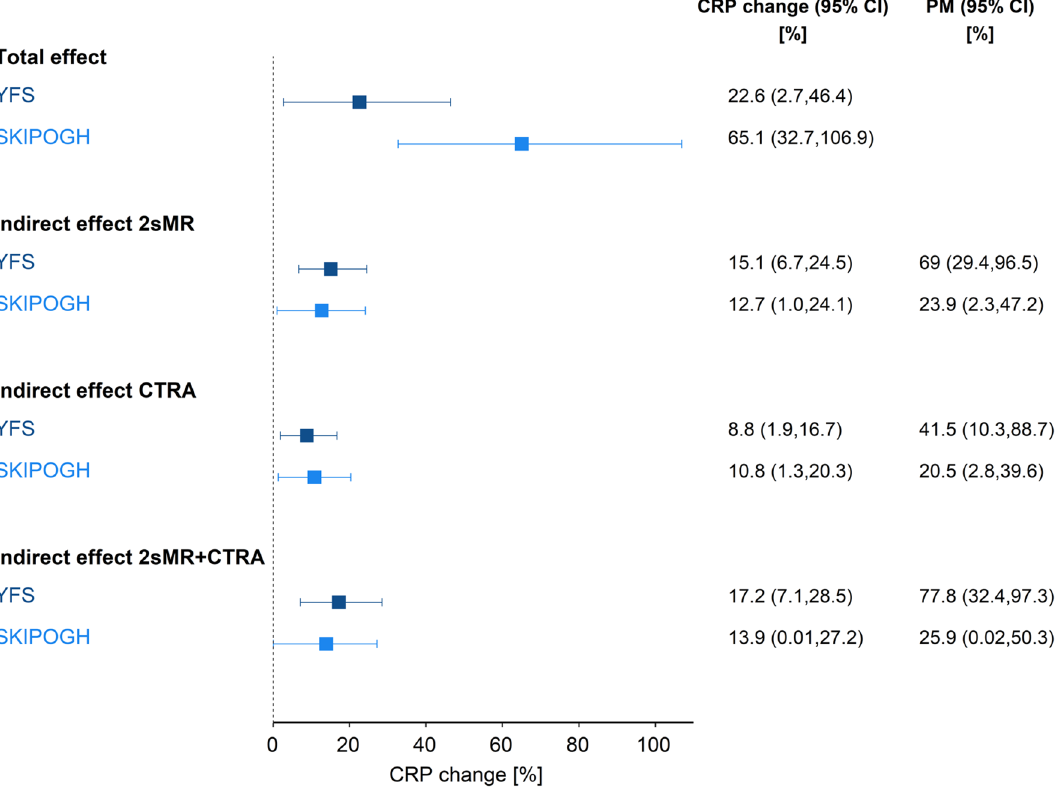
Figure 1. Amount of mediation by gene regulation. Size of effects and proportion mediated (PM) estimated by mediation analysis in each population. CRP change (%) and 95% confidence intervals (CI) are reported for the total effect of low (vs high) parental occupational position on CRP levels in adulthood, and for indirect effects through transcription levels of selected genes en-bloc . Joint indirect effects via 2sMR, CTRA or 2sMR + CTRA genes were estimated by summarizing transcription levels with principal components corresponding to about 50% of the transcription variance in each genes’